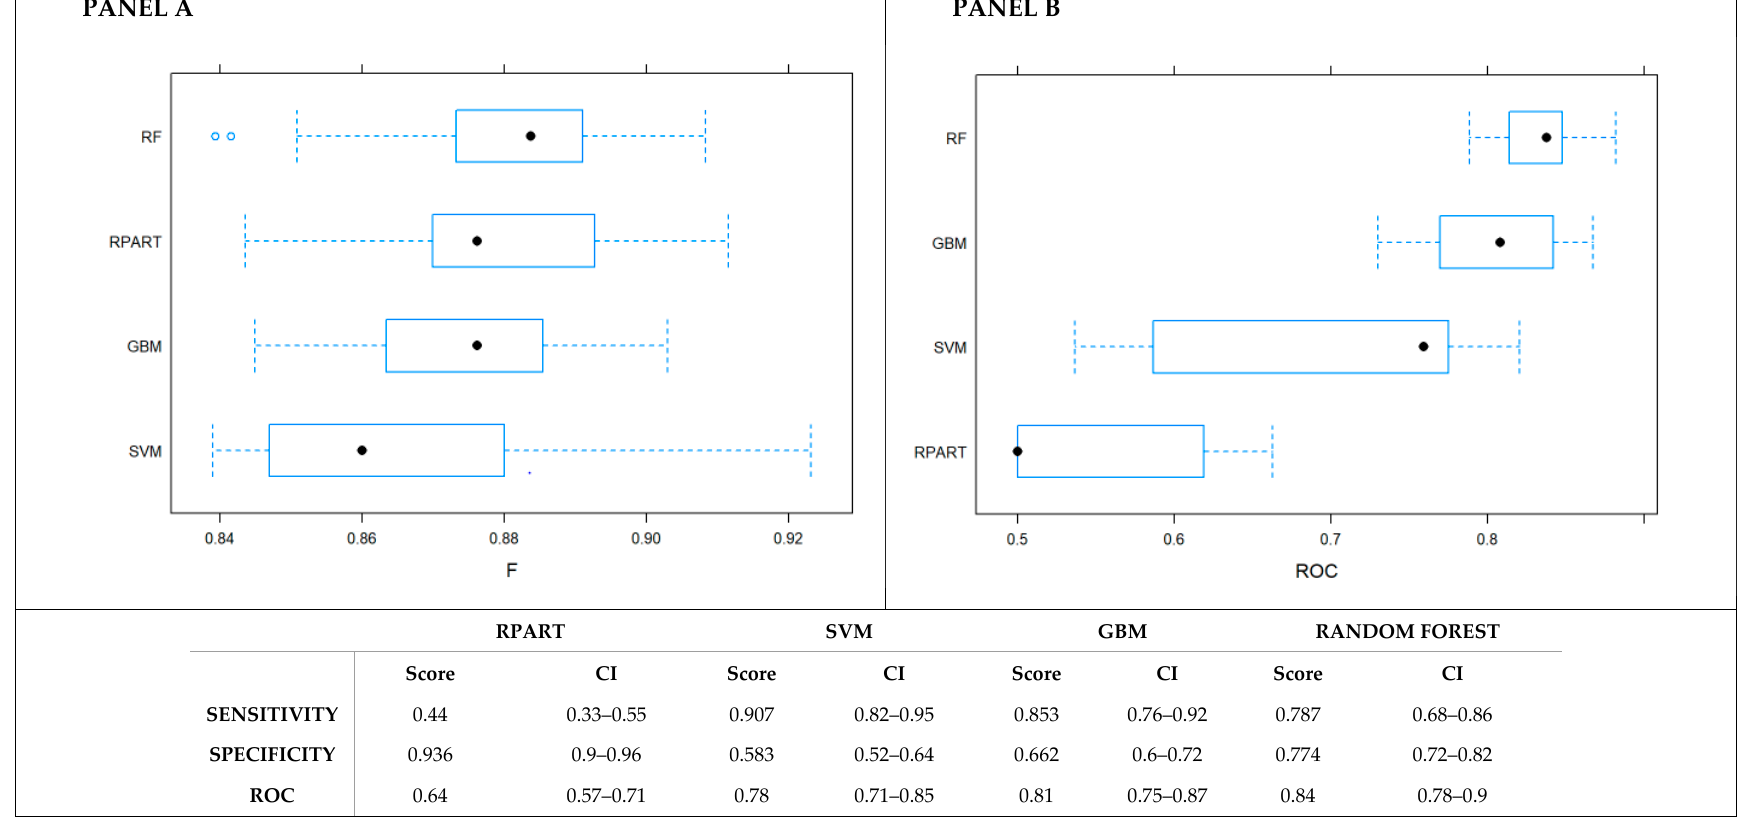
Figure 1. Comparison of the performance of the MLT algorithms. Panel A presents the F-score measure. Panel B presents the ROC.